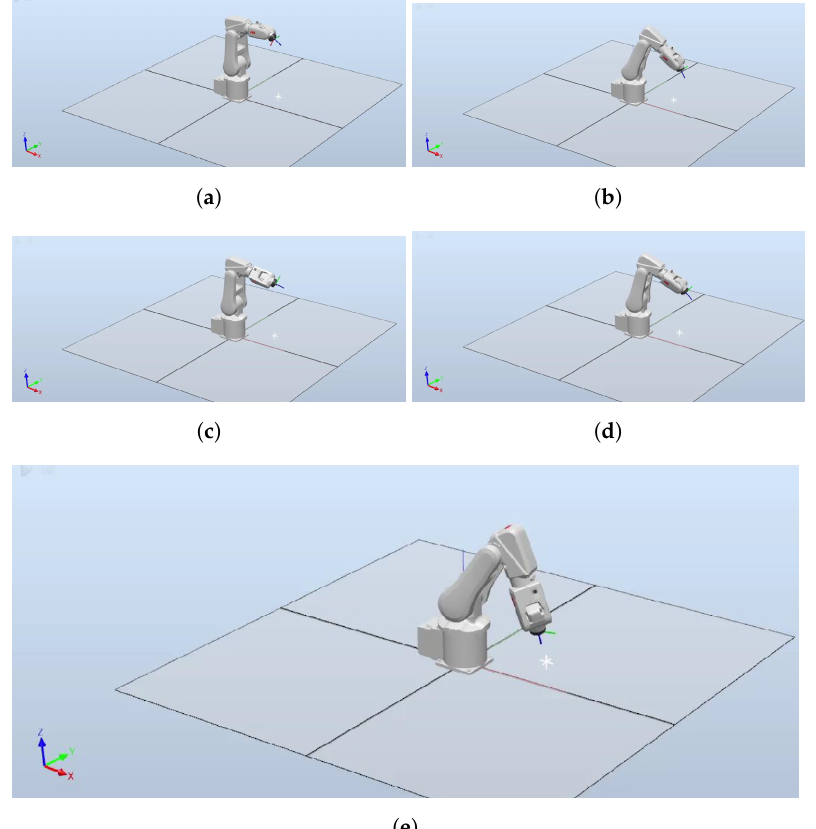
Figure 15. An illustration of the generated path. ( a ) The initial step of the simulated trajectory. ( b ) The sixth step of the simulated trajectory. ( c ) The twelfth step of the simulated trajectory. ( d ) The eighteenth step of the simulated trajectory. ( e ) The twenty-fourth step of the simulated